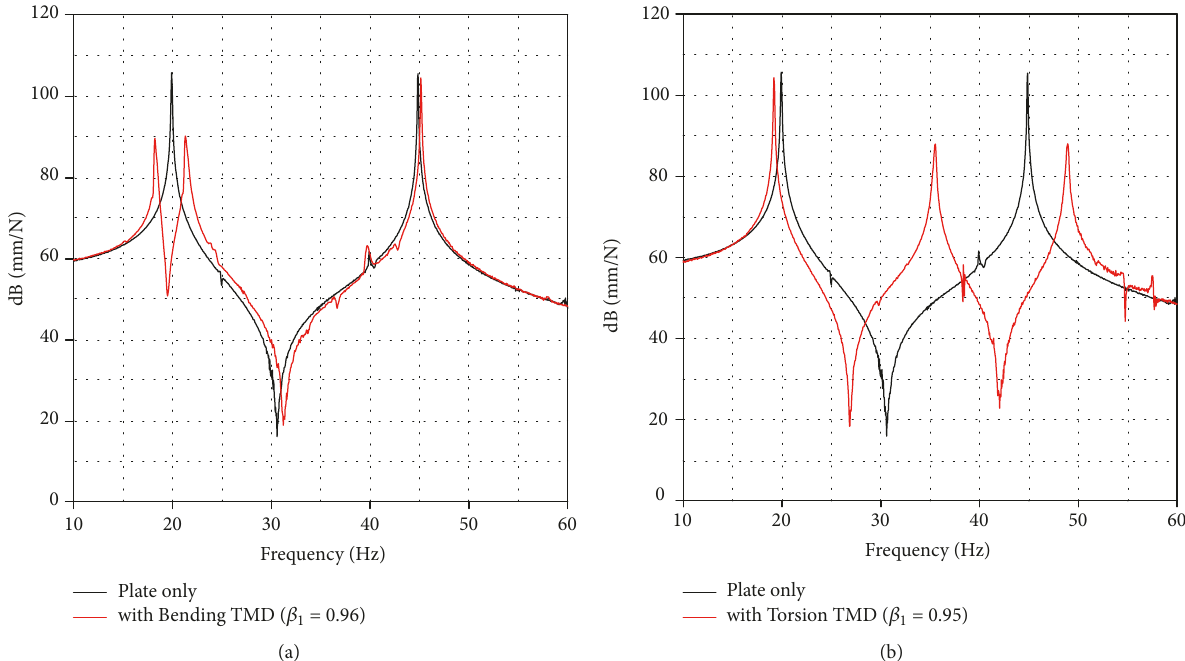
Figure 12: Experimental FRF results of the primary structure with each TMD: (a) with the first TMD only and (b) with the second TMD only (Key: black line, Primary: red line, TMD).